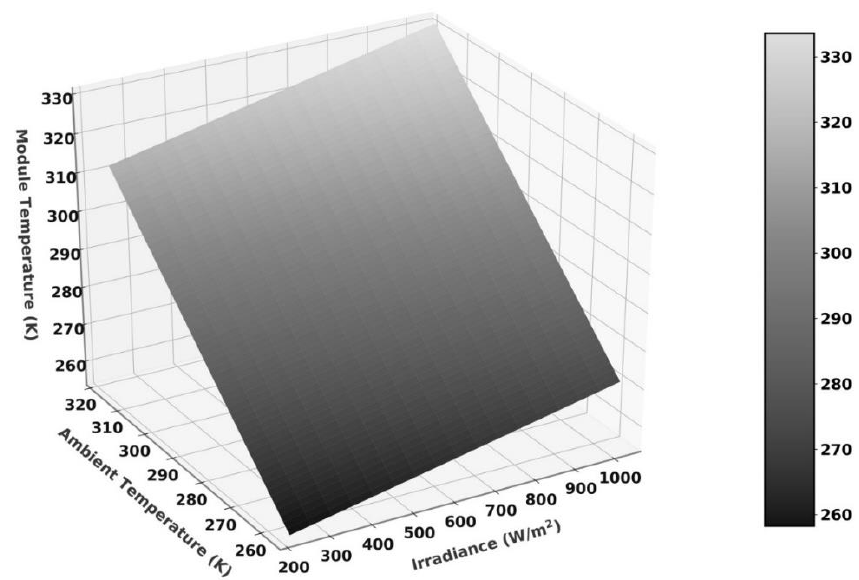
Figure 8. Irradiance vs. ambient temperature vs. module temperature by five parameters model.